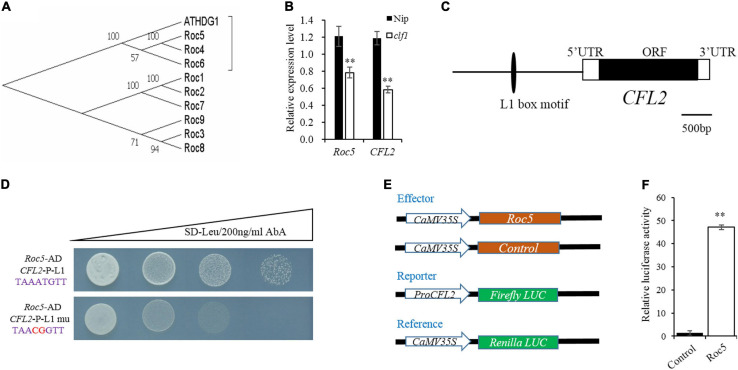
CFL2 may be a target gene of Roc5. (A) Phylogenetic tree of ATHDG1 and the nine numbers of HD-ZIP IV family gene in rice. (B) Expression of Roc5 and CFL2 in Nipponbare (Nip) and the clf1 mutant. Values are means ± SD (n = 3). Student’s t-test was used for statistical analysis (∗∗P < 0.01). (C) Distribution of the L1 box motif in the promoter regions of CFL2. (D) Yeast one-hybrid assay. (E) Schematic diagram show the constructs used in dual-luciferase assay. The empty pGreenII 62-SK vector was used as a control. (F)
Roc5 activates the expression of CFL2 in rice protoplasts. Values are means ± SD (n = 3). Student’s t-test was used for statistical analysis (∗∗P < 0.01).